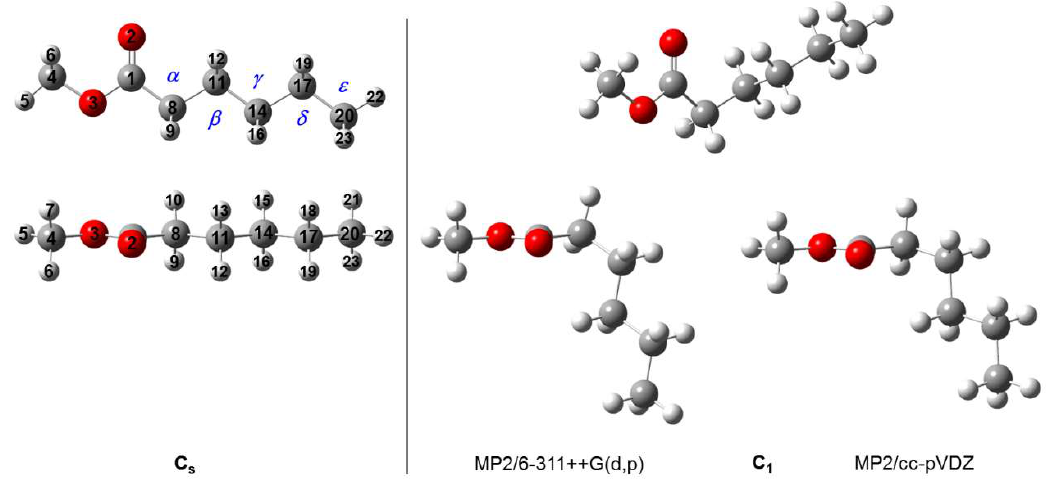
Figure 1. The two observed conformers C s ( left hand side) and C 1 ( right hand side) of MHO optimized at the MP2/6-311++G(d,p) and MP2/cc-pVDZ levels of theory. Atom numbering is given at the C s conformer. Grey atoms are carbon, white atoms are hydrogen and the red ones are oxygen. Upper trace: View on the O–(CO)–C plane; lower trace: view along the O2=C1 bond. The starting geometries of MHO were created by adjusting the dihedral angles 1 = ∡ (O3−C1−C8−C11), 2 = ∡ (C1−C8−C11−C14), 3 = ∡ (C8−C11−C14−C17), and 4 = ∡ (C11−O14−C17−C20). The rotations about the O3−C4 and C17−C20 bonds correspond to